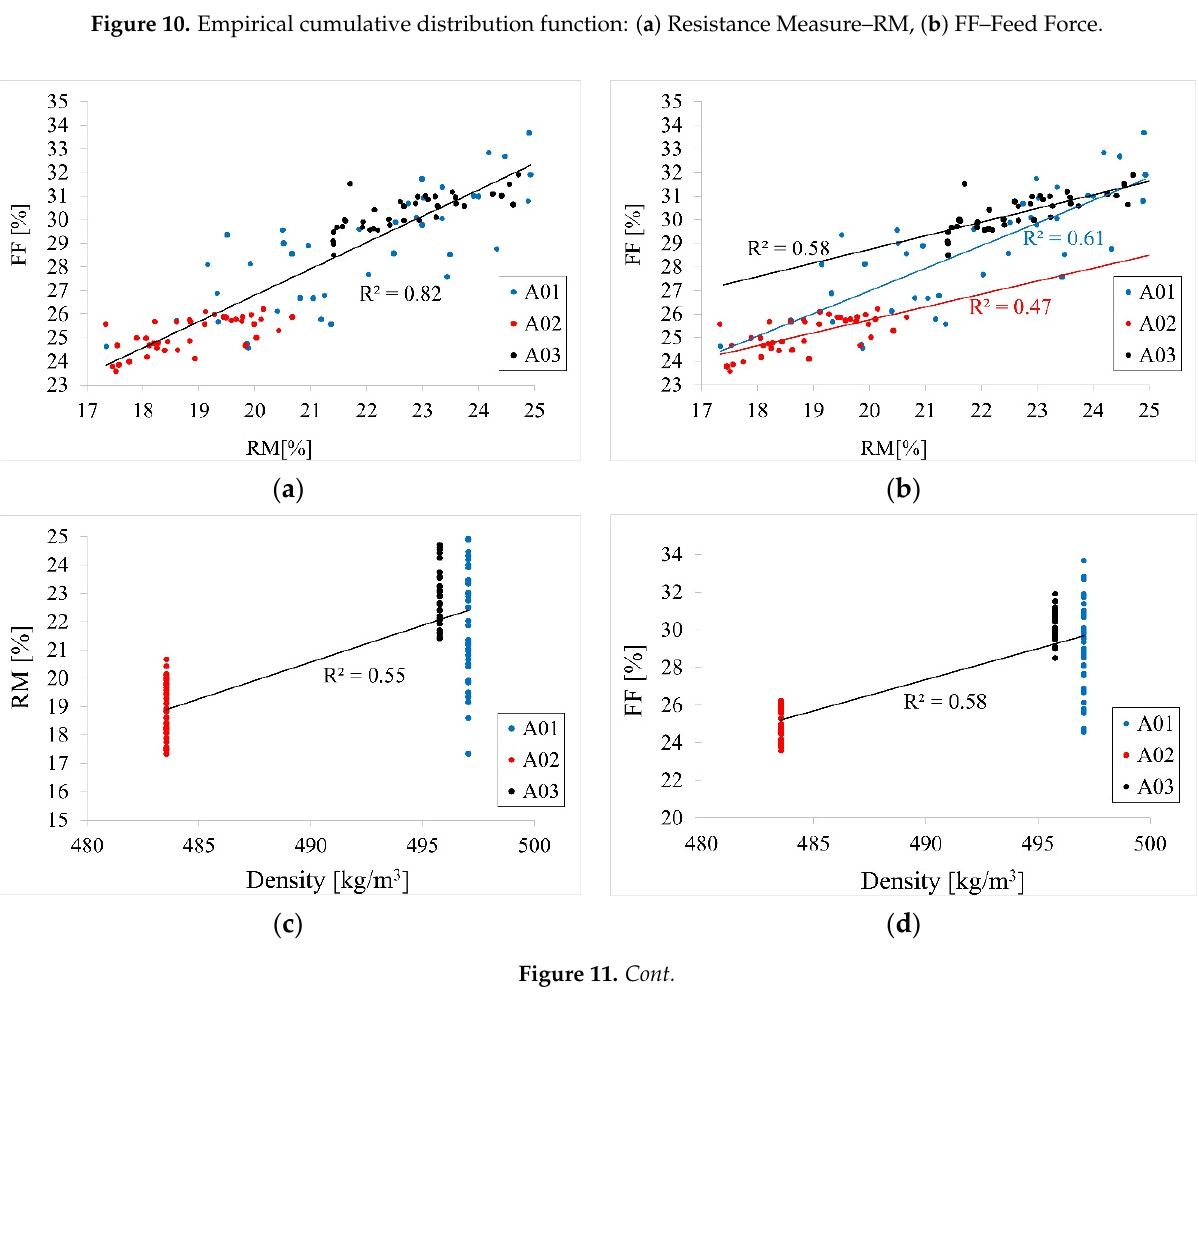
Figure 10. Empirical cumulative distribution function: ( a ) Resistance Measure–RM, ( b ) FF–Feed Force. Based on the FF and RM values determined, statistical analyses were carried out to find the relationship between these values and the MOR, MOE, and density of elements on the technical scale.